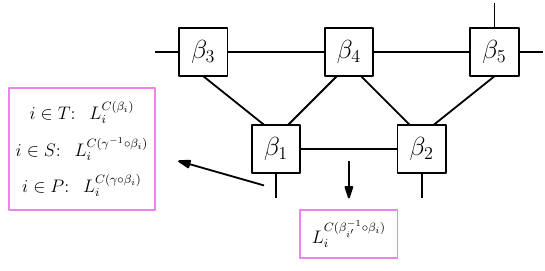
Figure 17 . A generic tensor network in terms of